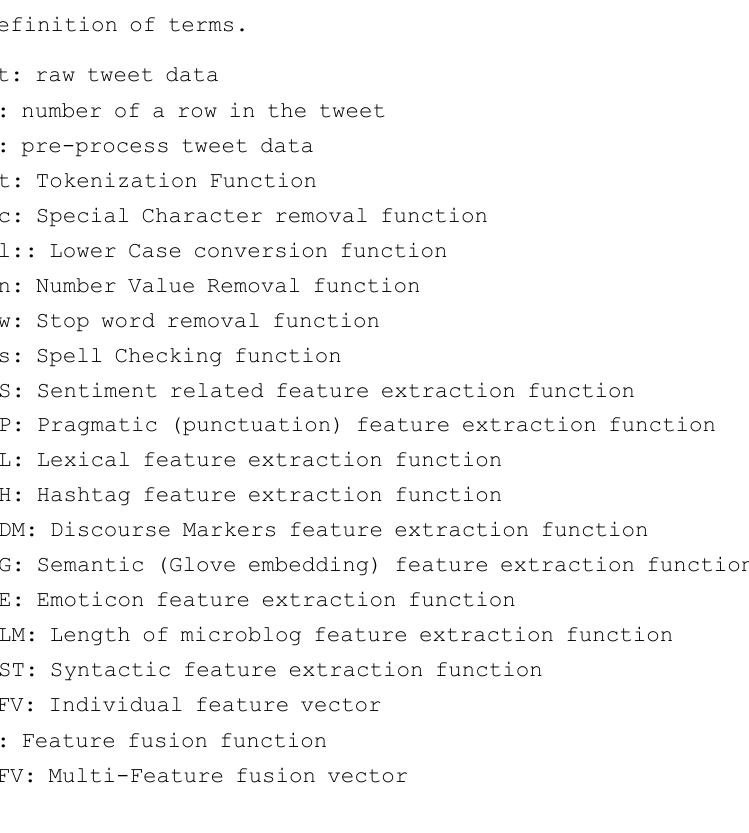
Algorithm 1: Data pre-processing, feature extraction and feature fusion